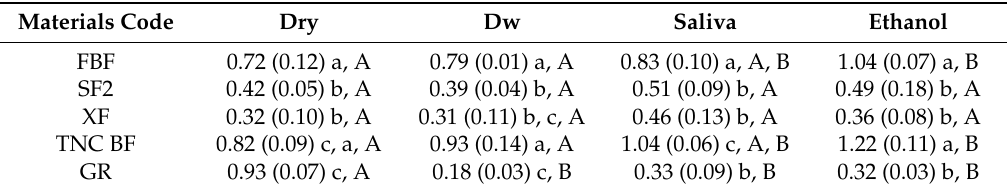
Table 6. Max recovery strain